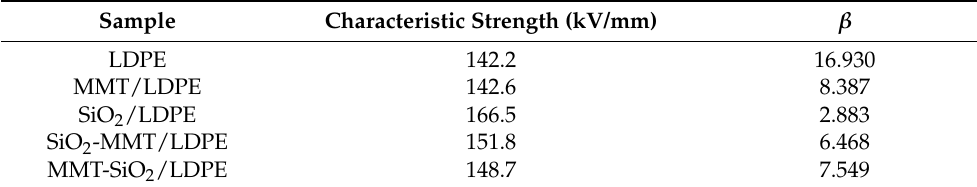
Table 3. Characteristic breakdown field strength of each